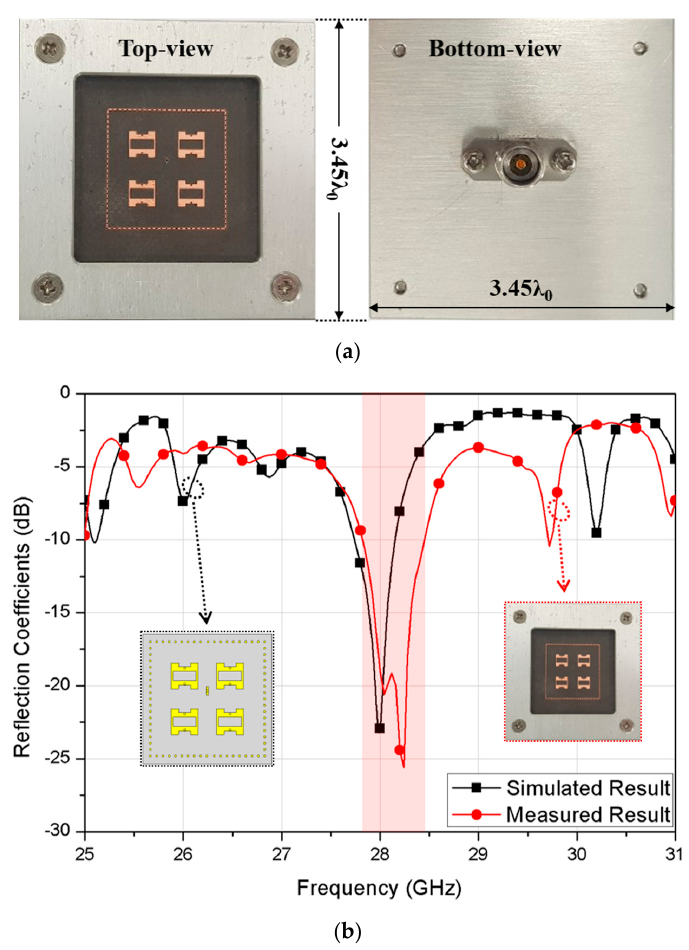
Figure 6. Implementation of the proposed 2 × 2 array antenna with ( a ) fabrication photo and ( b ) simulated and measured reflection coefficients. simulated and measured reflection coe ffi